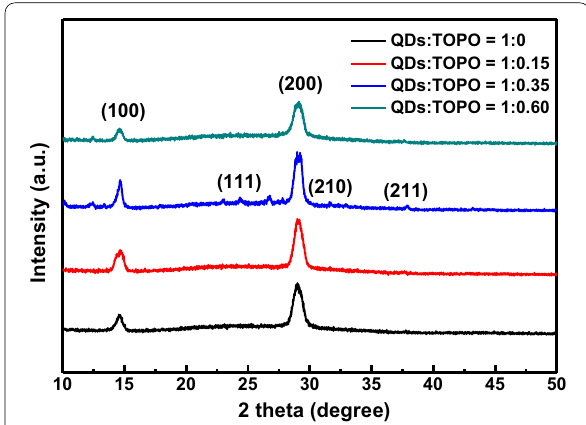
Fig. 3 X‑ray diffraction (XRD) patterns of CsPbI 3 /TOPO composite films with different ratios